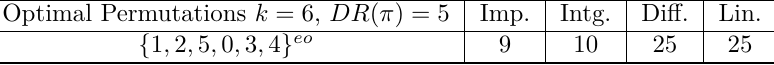
Table 10: Optimal permutations for k = 6 up to extended pair-equivalence Optimal Permutations k = 6, DR ( π ) = 5 Imp. Intg. Diff.